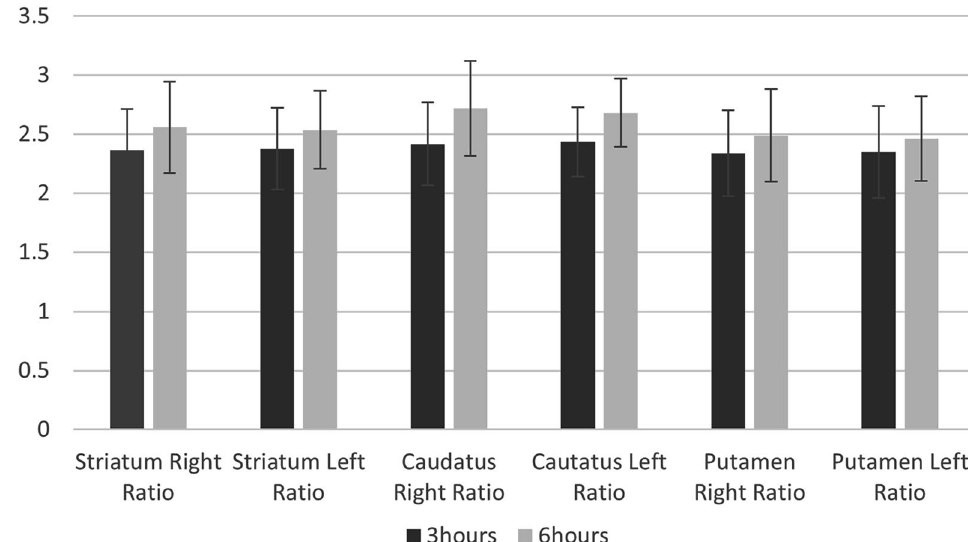
Fig. 3 Analysis of striatal binding ratio (SBR) at 3 and 6 h after administration of [ 123